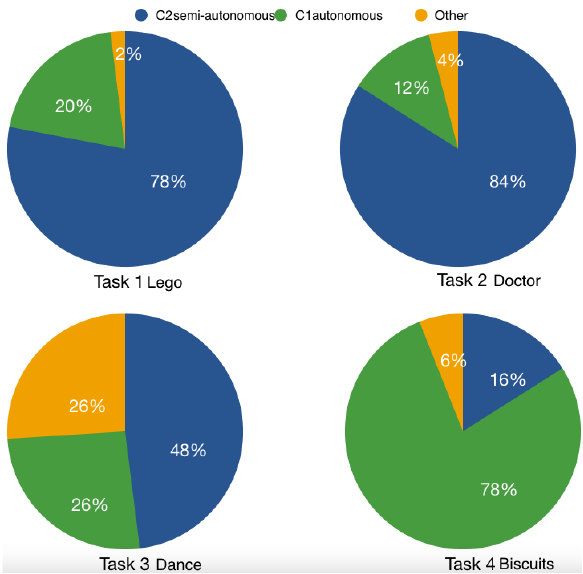
Figure 5: Preferred conditions for each task.